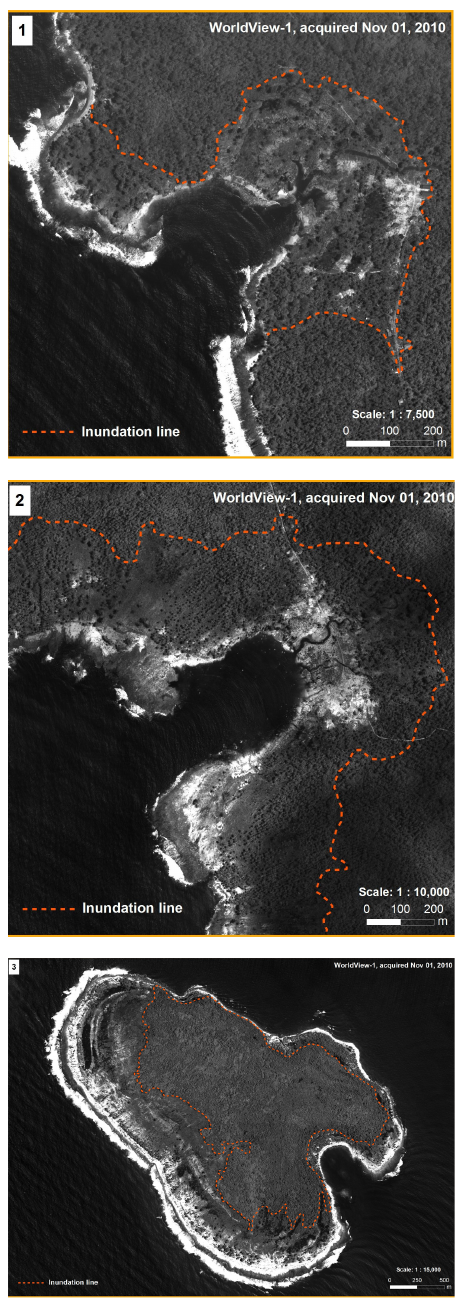
Fig. 11. Damage Extent Map (Reliefweb, 2010).